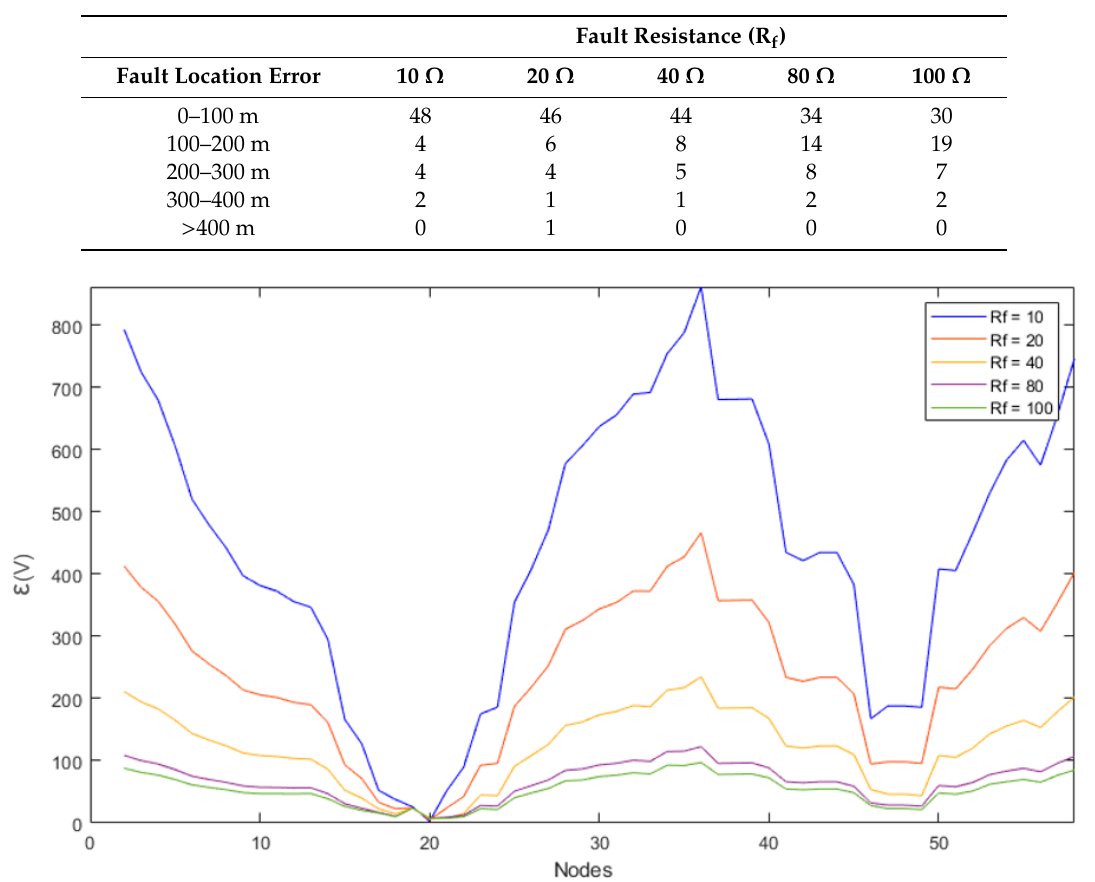
Figure 9. Voltage profiles considering different faults resistance.